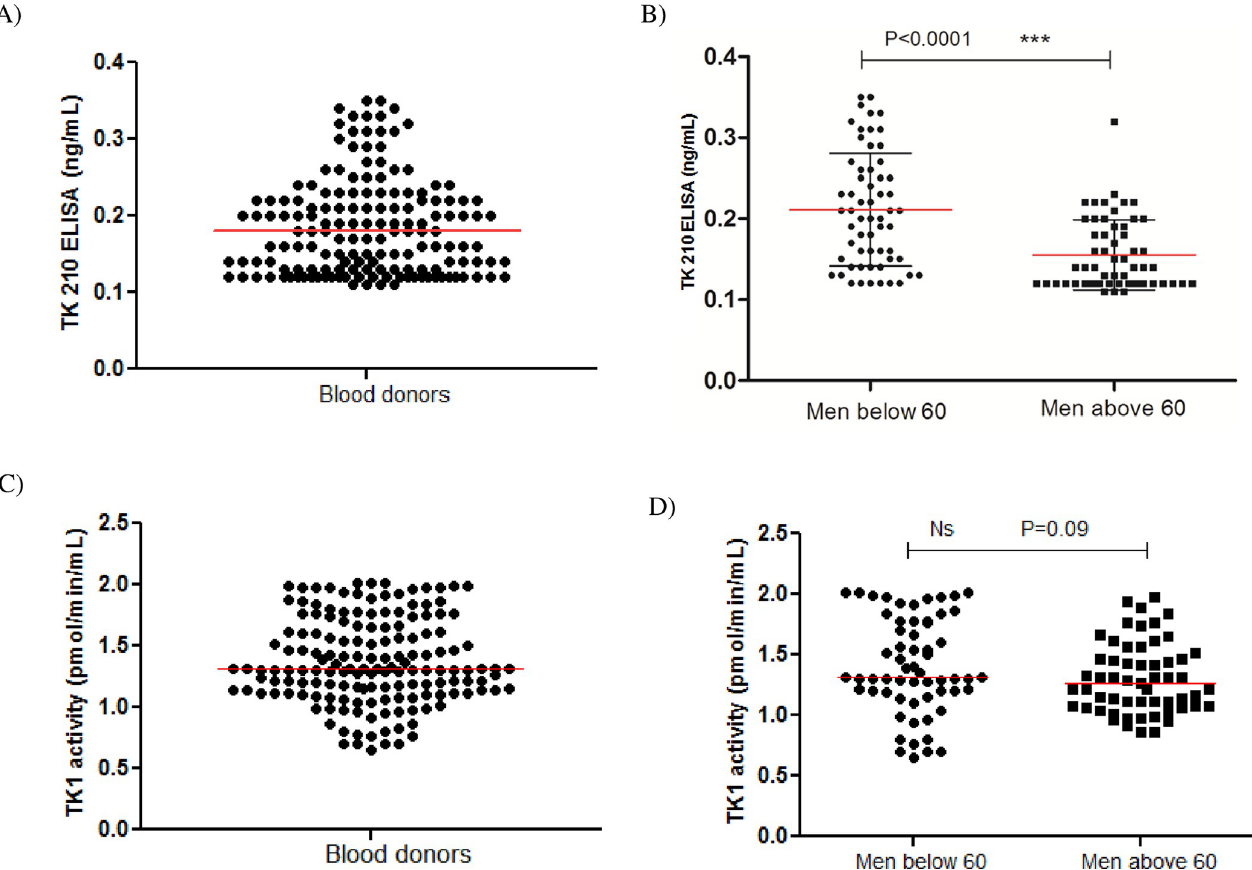
Fig 5. The distribution of serum TK1 protein and TK1 activity in blood donor samples (n = 159). (A) Serum TK1 protein distribution in blood donor sera (n = 159) (B) A comparison of TK1 concentrations in sera from blood donor men below 60 years ( ● ) and men above 60 years ( ■ ). The error bars indicate the median (red). (C) Serum TK1 activity levels in blood donor samples (n = 159). (D) Comparison of TK1 activity in sera from blood donor men below 60 years ( ● ) and men above 60 years ( ■ ). The error bars indicate the median (red).